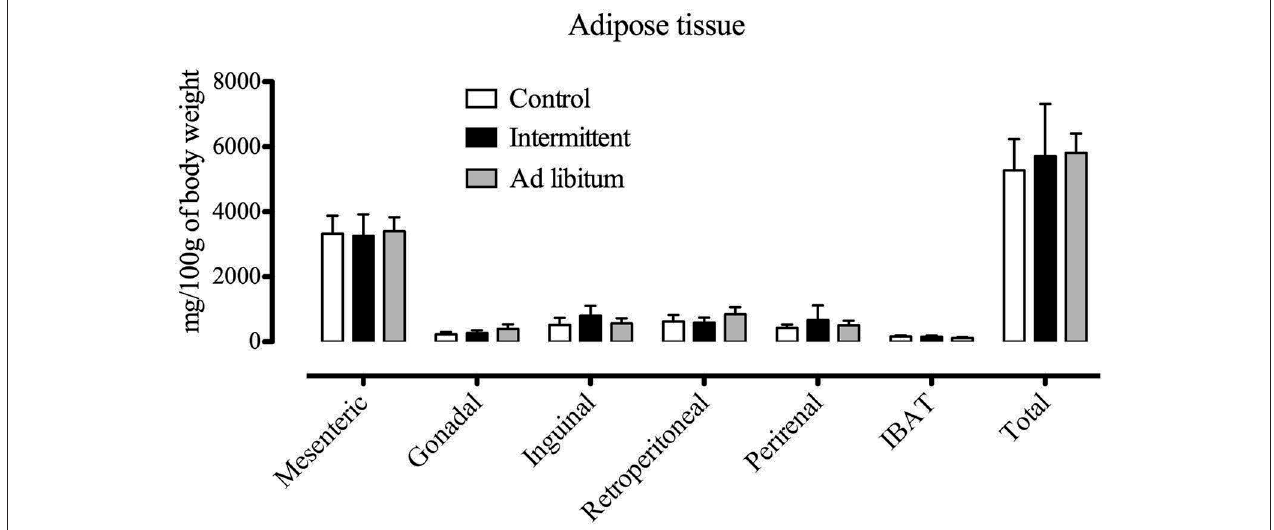
FIGURE 2 | Measurements of adipose tissue in specific regions after the 28 days of exposition to the sucrose solution ( n = 4 each group, control, intermittent, and ad libitum ). Data are expressed as the normalization of mg of adipose tissue per 100g of body weight. IBAT, interscapular brown adipose tissue (means ±